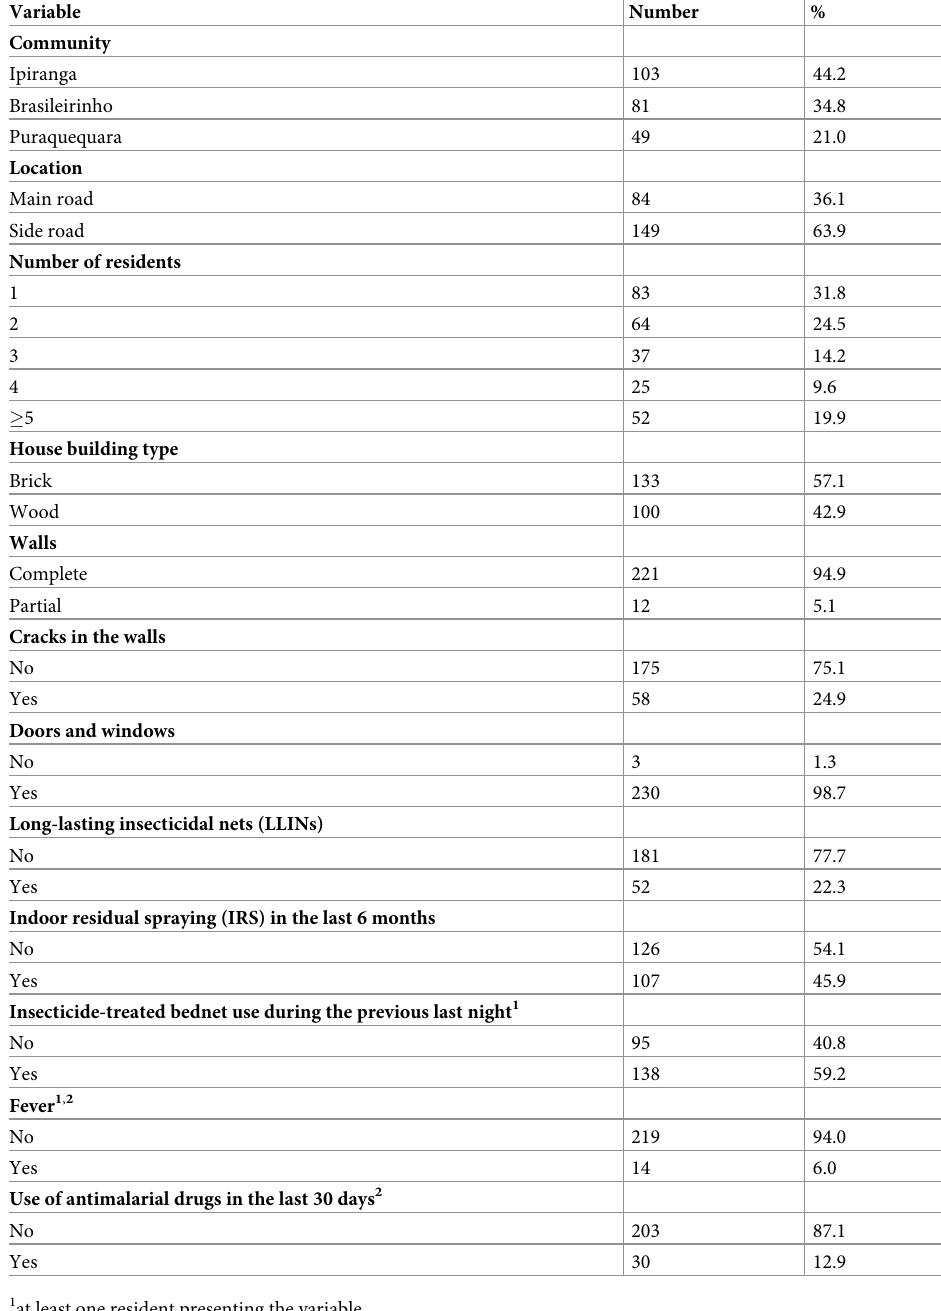
Table 1. Characteristics of the households sampled for mosquito